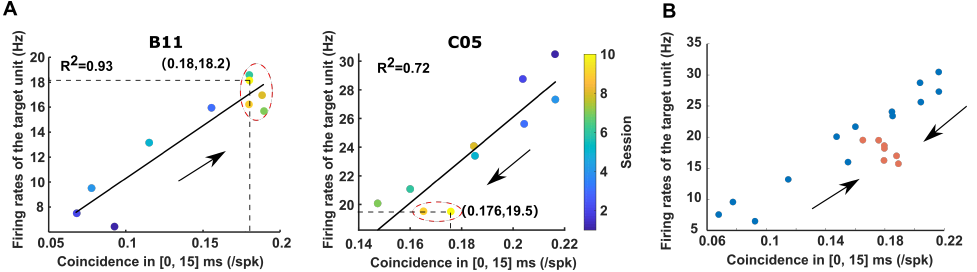
Figure 7. Evolution of rewarded neural patterns throughout learning. ( A ) The CCH coincidence in [0, 15] ms is correlated with the firing rates of the target unit for both subjects ( Left : B11, p = 1.05 × 10 − 4 ; Right : C05, p = 9 × 10 − 4 ). However, the evolution showed opposite directions, as indicated by the arrows. The coordinates of the last session are labeled. ( B ) Rewarded neural patterns of both subjects under the same neural space. Each dot represents the averaged neural pattern in one session. Neural patterns from stable sessions are indicated by the orange